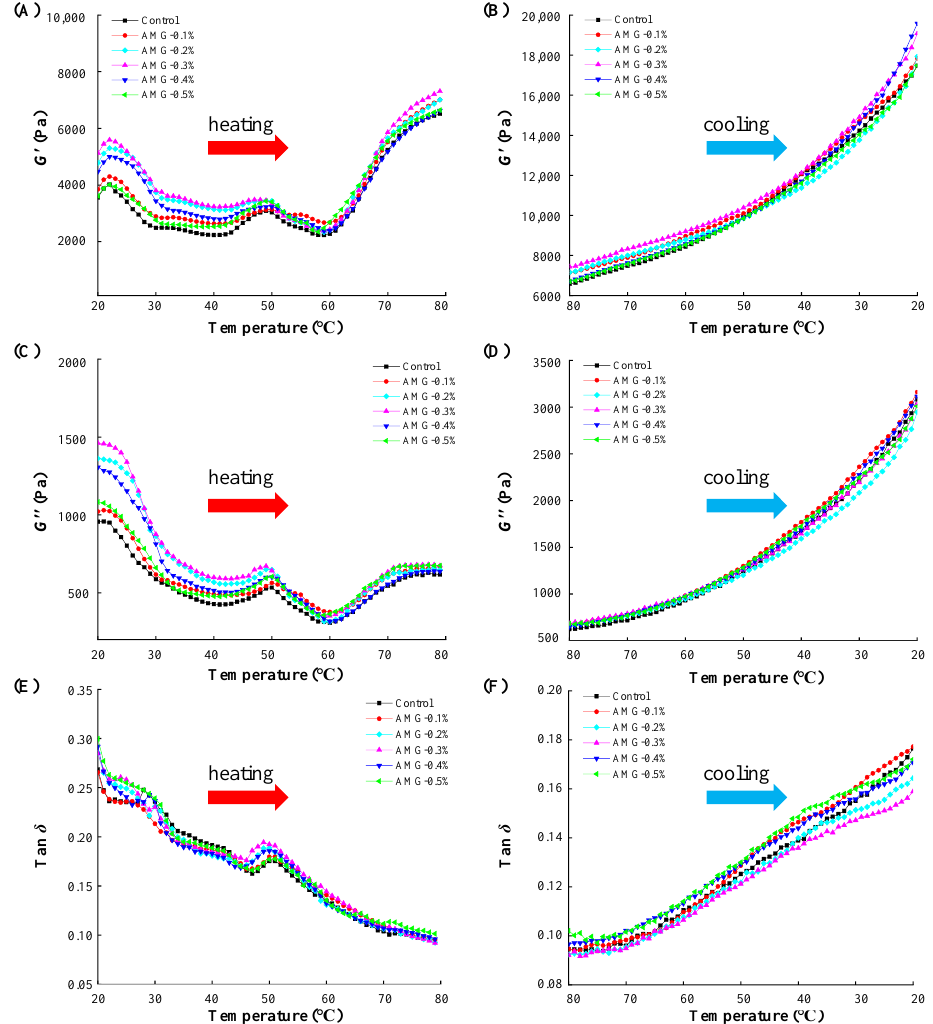
Figure 1. The rheological behaviour (storage modulus ( G′ ); loss modulus ( G′′ ); and loss tangent (tan δ )) of meat batters with or without AMG at different concentrations. ( A , C , E ) represent the heating treatment (from 20 °C to 80 °C). ( B , D , F ) represent the cooling treatment (from 80 °C to 20 °C). Control: no added AMG; AMG-0.1%: 0.1% added AMG; AMG-0.2%: 0.2% added AMG; AMG-0.3%: 0.3% added AMG; AMG-0.4%: 0.4% added AMG; and AMG-0.5%: 0.5% added AMG.